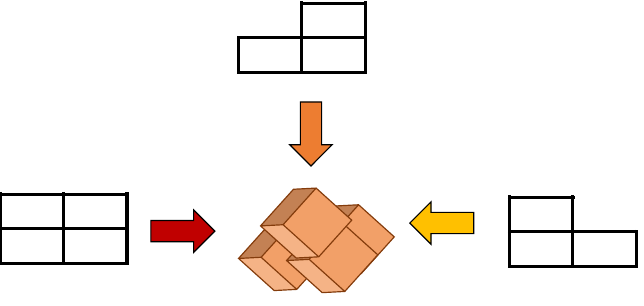
Figure 4. Data analysis on the viewpoint direction. Dataset = TN where T = SC (2) The eigenface was then obtained from differentiated 3D EEG image, and newly ob- tained image data Φ and value Ψ need to be calculated.